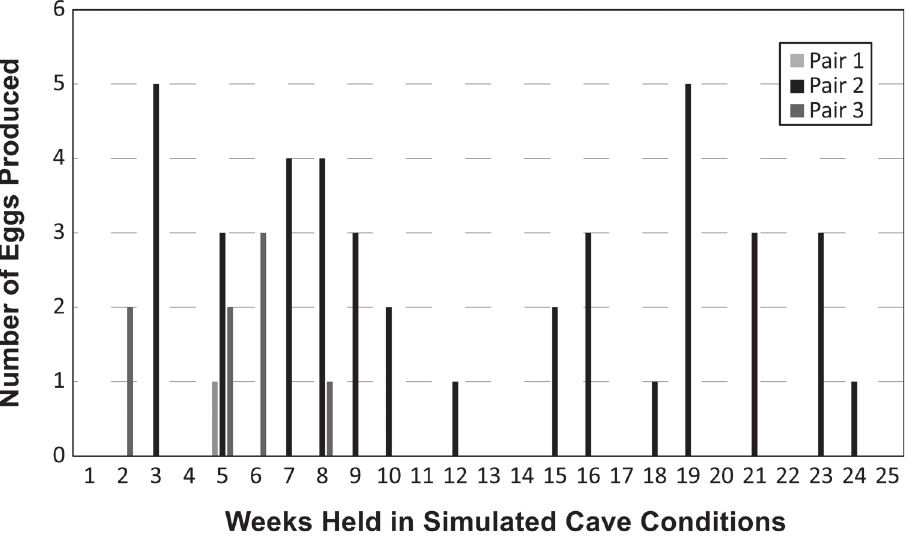
Figure 4. Pattern of egg production by Fontigens antroecetes from Stemler Cave, Illinois over 25 weeks in simulated cave